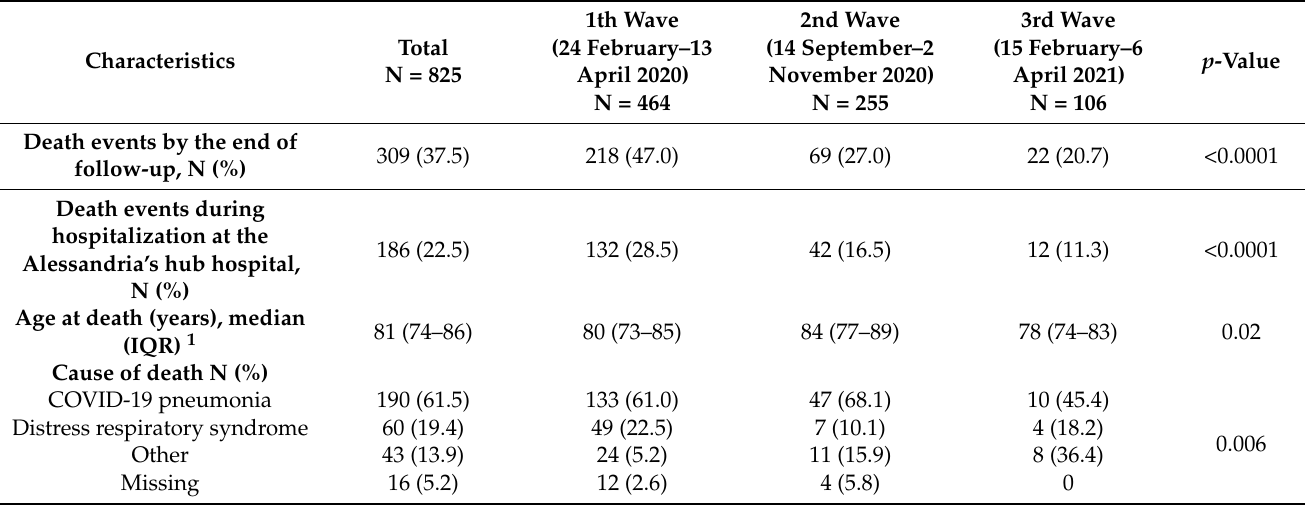
Table 2. Description of the mortality of patients hospitalized during the first fifty days of the first three COVID-19 pandemic